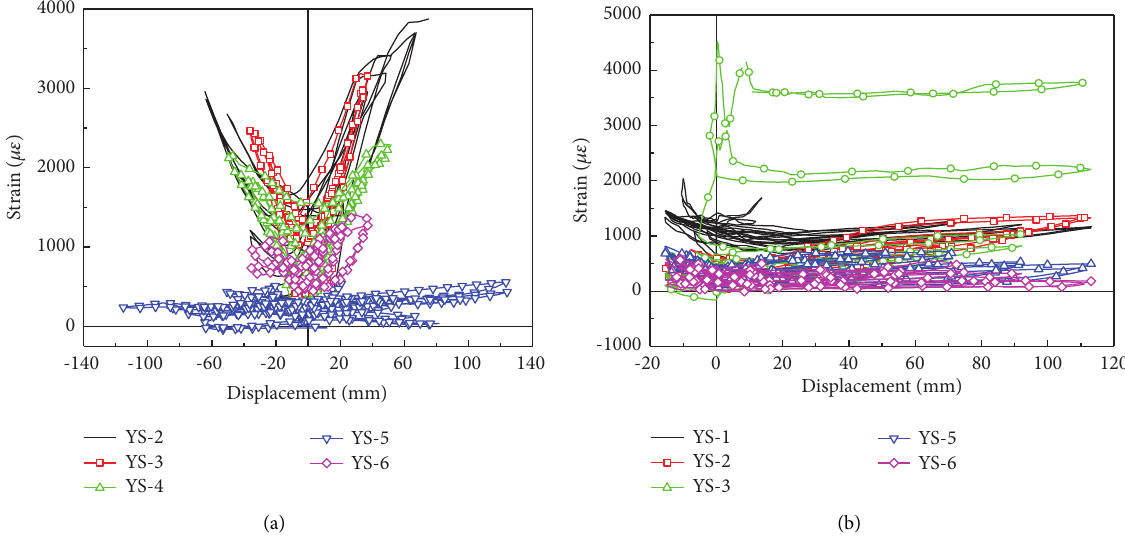
Figure 9: Joint stirrup strain versus deformation relationships of specimens: (a) specimen CMJ and (b) specimen